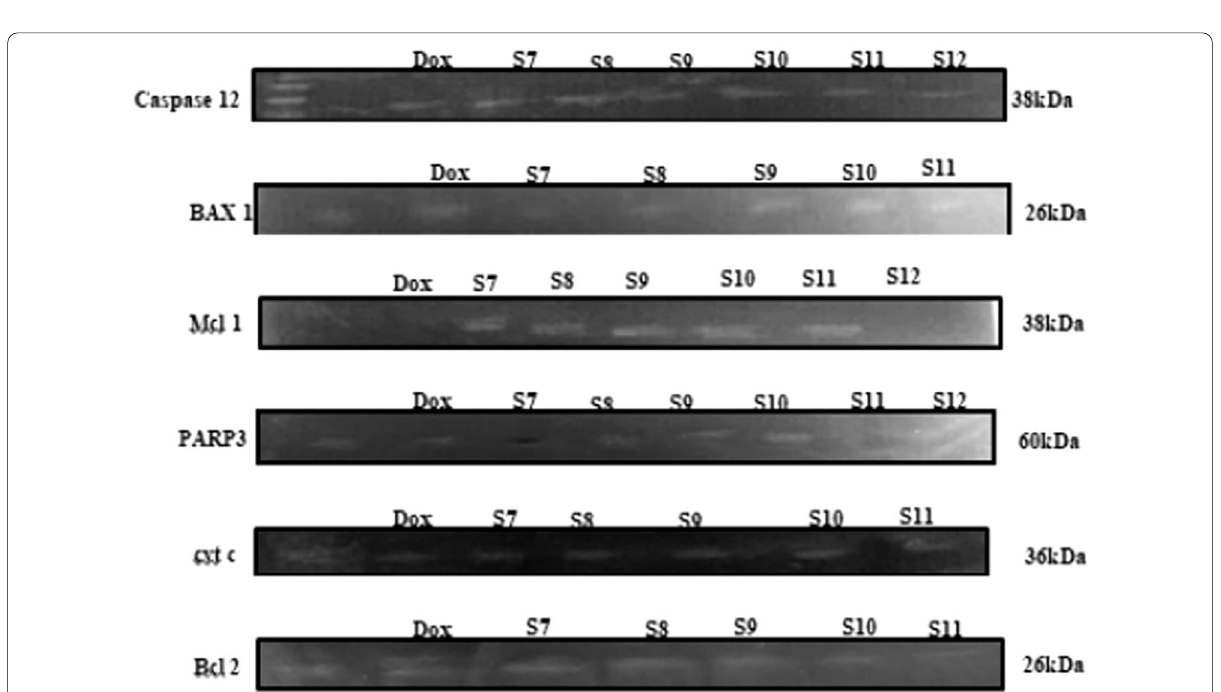
Fig. 6 Gel 1—Expression of apoptotic proteins with respective positive bands at 38 kDa for Caspase 12, 38 kDa for Mcl 1, 26 kDa for BAX, 26 kDa for Bcl 2, 36 kDa for cyt c, 60 kDa for PARP3, Dox—Doxorubicin, S7—NP2, S10—NP14, S8—NC1, S11—NC6 Dox, S9—NC2,